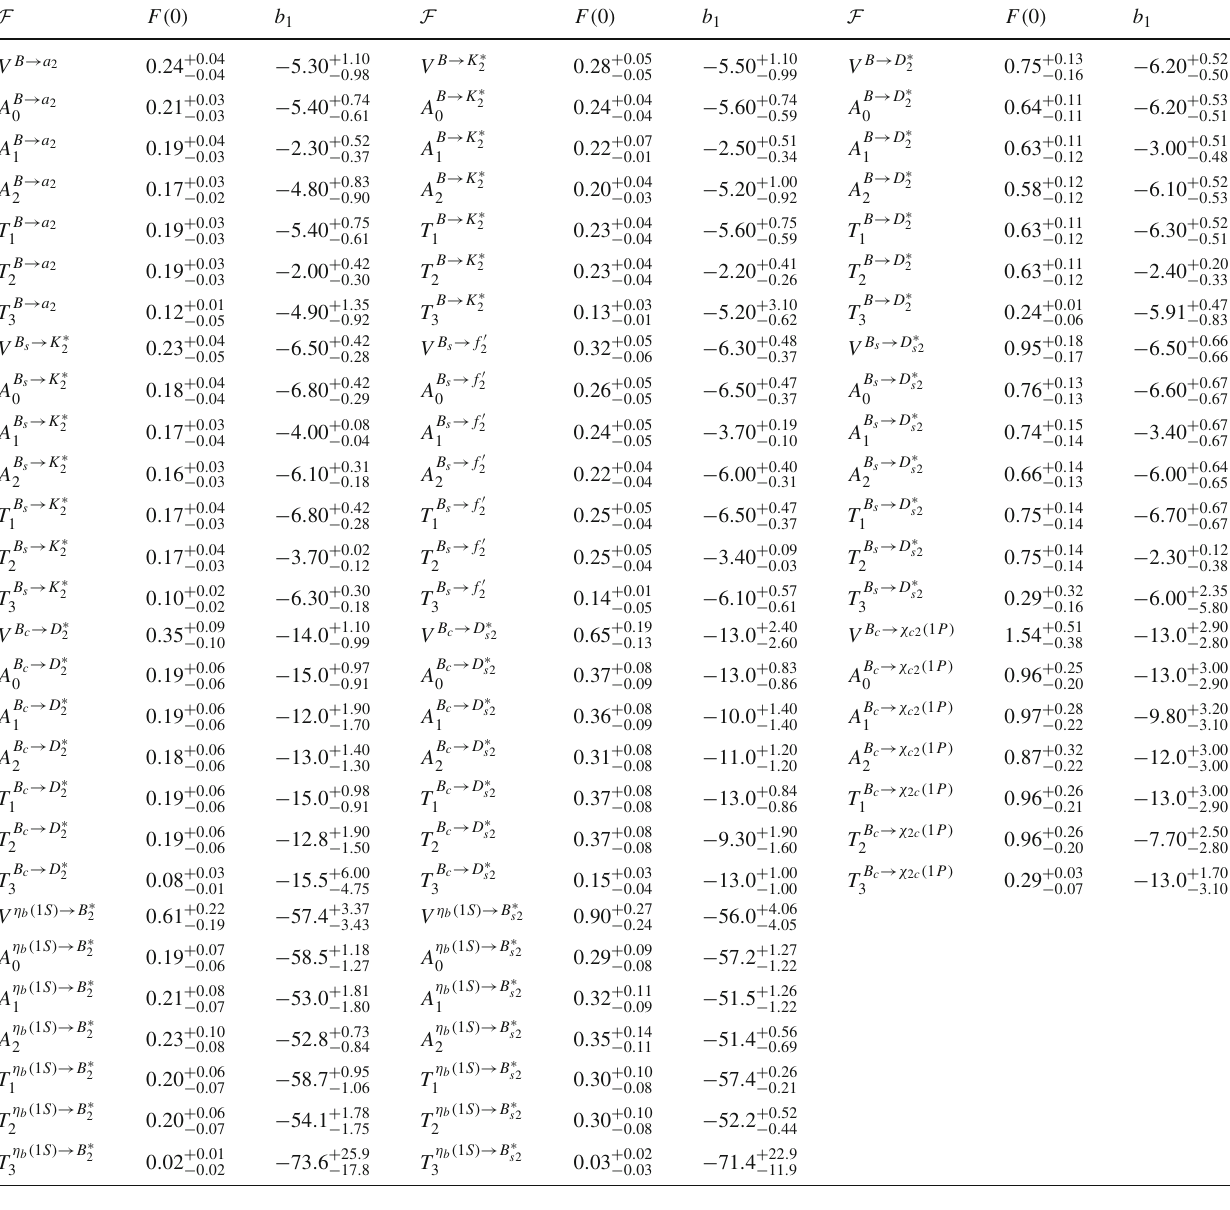
Table 4 Fitting results for form factors of b → ( q , s , c ) induced B → ( a 2 , K ∗ η ( 1 S ) → ( B ∗ b